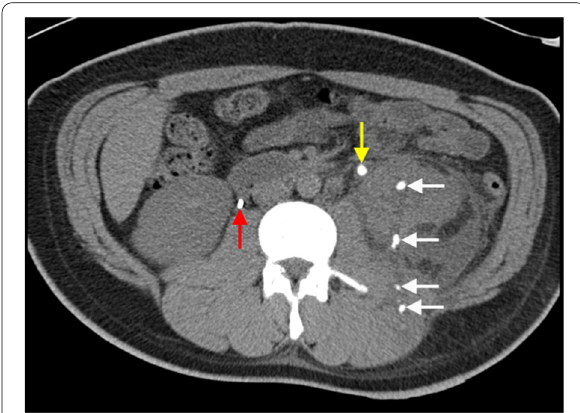
Fig. 7 Unenhanced CT image of migration of renal calculi (white arrows) into the left percutaneous nephrolithotomy tract and a small left perinephric urinoma post-PCNL of a left staghorn calculus. There is a inferior migration of the ureteric calculus within the left proximal ureter (yellow arrow). A right-sided ureteric stent is in situ (red arrow)